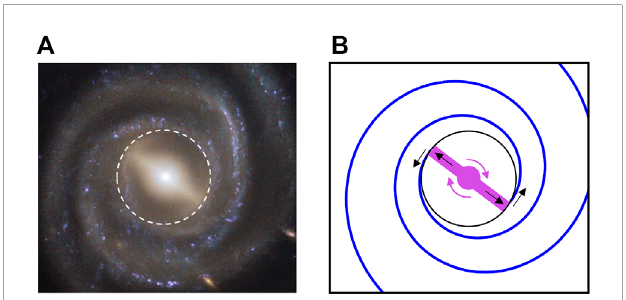
FIGURE 3 The spiral galaxy UGC 6093 observed by ESA/Hubble (A) and the scheme of the spiral galaxy (B) . The bulge and bar of the galaxy in plot (B) is marked by the purple colour. The purple arrows in (B) show the rotation direction of the bar. The black arrows in (B) show the direction of the outflow from the bulge-bar domain into the spiral domain. The white dashed circle in (A) and the solid black circle in (B) mark the boundary between the bulge-bar and spiral domains.